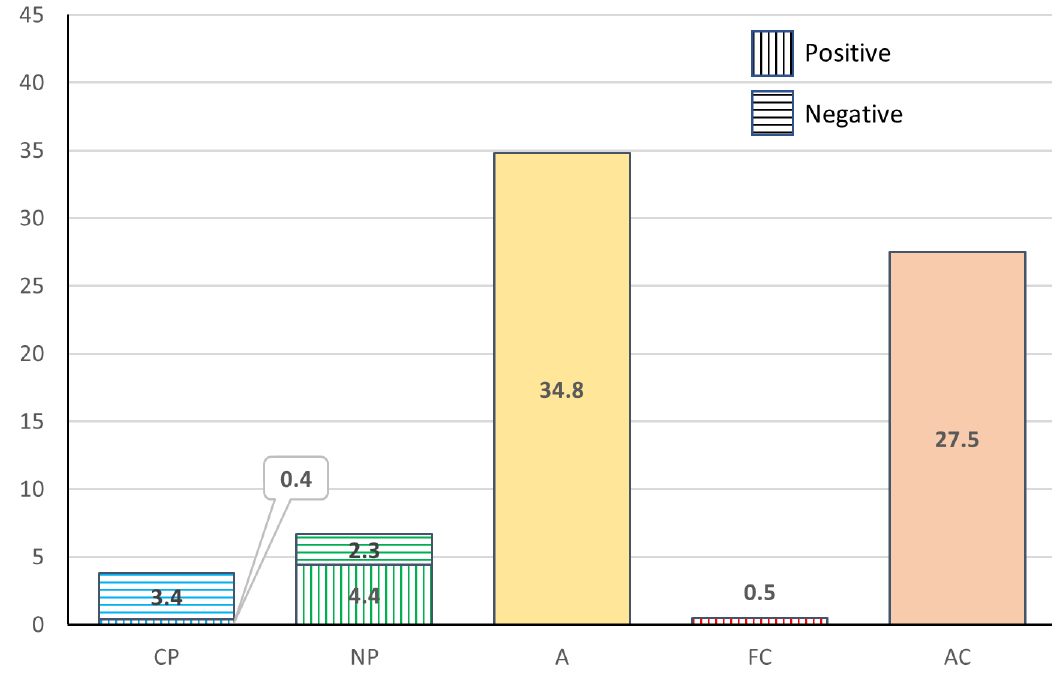
Figure 1: Completed Suicide Egogram